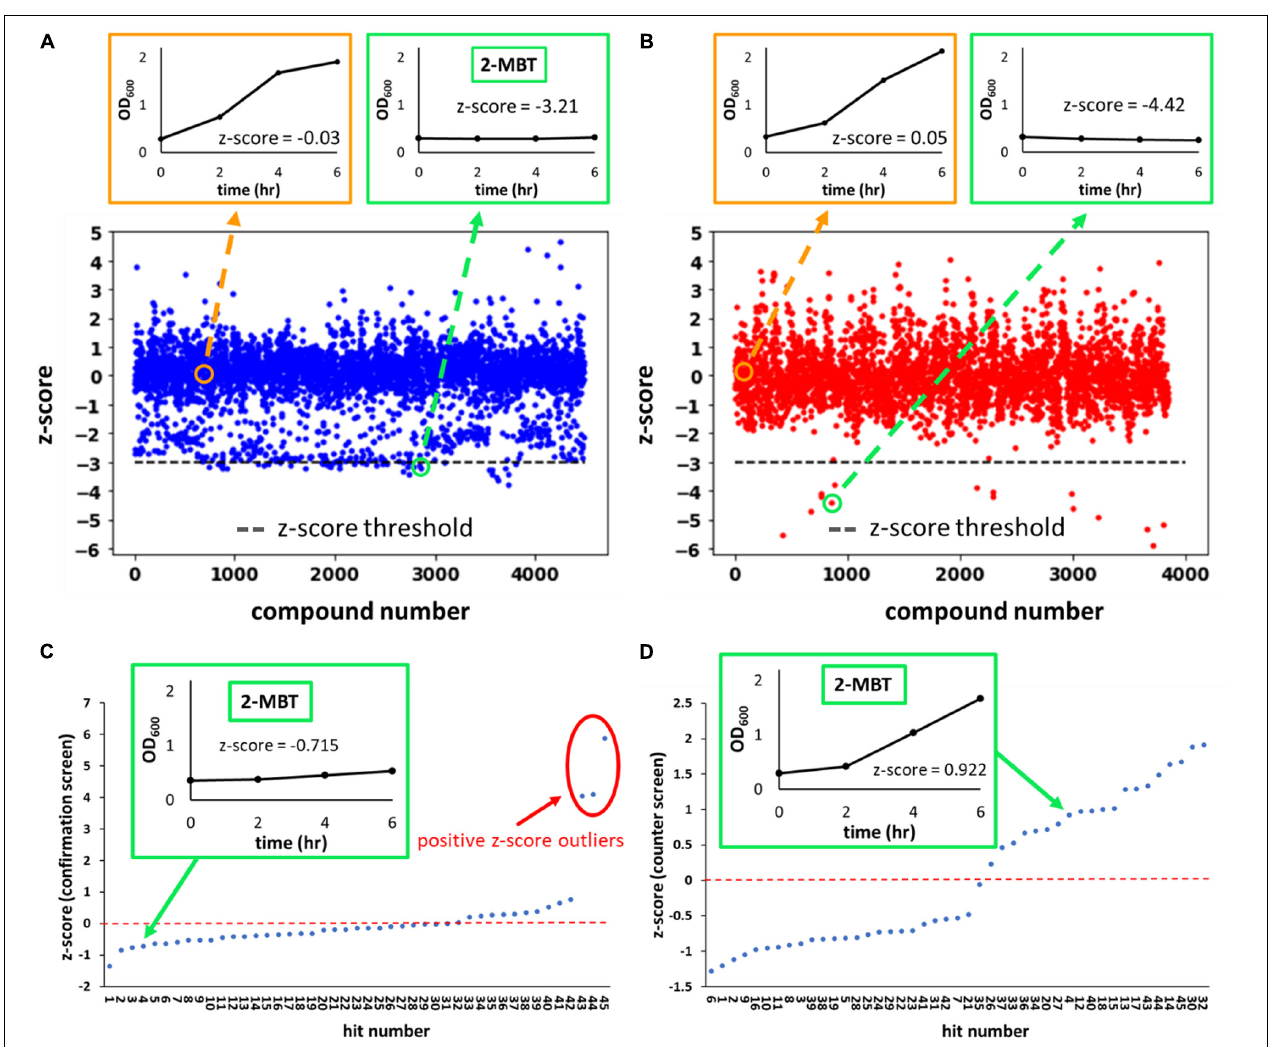
FIGURE 2 | z -score from the initial, confirmation and counter screens. In (A,B) , the z -scores of every compound evaluated during the initial screen are plotted. Compounds were from two sub-libraries: one containing compounds with demonstrated biological activity (biologically active library) (A) and the other representing a general small molecule library (generic library) (B) . A total of 8,320 compounds were tested in the initial screen, 4,480 of which came from the biologically active library and the remaining 3,840 from the generic library. Representative OD 600 profiles that either passed (outlined in green) or did not pass (outlined in orange) the z -score threshold of –3 (horizontal gray line) were plotted on the top. The growth curve associated with 2-MBT treatment from the initial screen is plotted in the green box in (A) . In (C,D) , the z -scores of hits from the initial screen during the confirmation and counter screens are plotted. In (C) , growth inhibition in the presence of NO was verified. Compounds with high z -scores allowed growth and were identified as outliers (circle in red). We note that since the confirmation screen only included hits, the z -scores between the primary screen and confirmation screen will not be the same. In (D) , growth in the absence of NO was measured. NO-specific growth inhibitors would not inhibit growth during this screen, so compounds with the higher z -scores allowed relatively better growth. A natural break in the data occurs around a z -score of 0 in the counter screen, therefore compounds with z -scores > 0 were identified as growth permissive. Of note, out of 20 compounds that had a positive z -score in the counter screen, 3 were outliers in the confirmation screen (C) and thus were disqualified, and 17 compounds were identified as hits from the screening